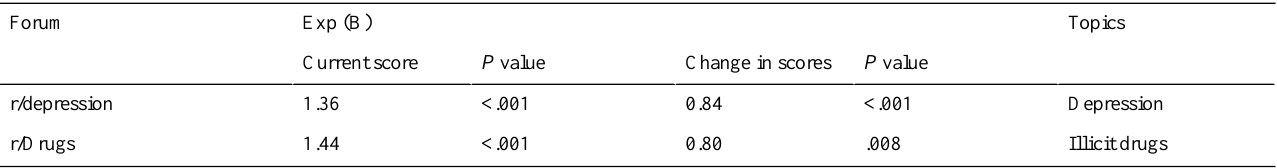
Table 2. Cox proportional-hazard model for future postings on different forums among the 50 most popular forums among people who posted in the loneliness